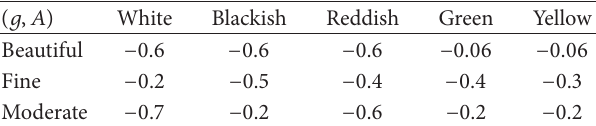
Table 5: Tabular representation of (𝑔,𝐴) .